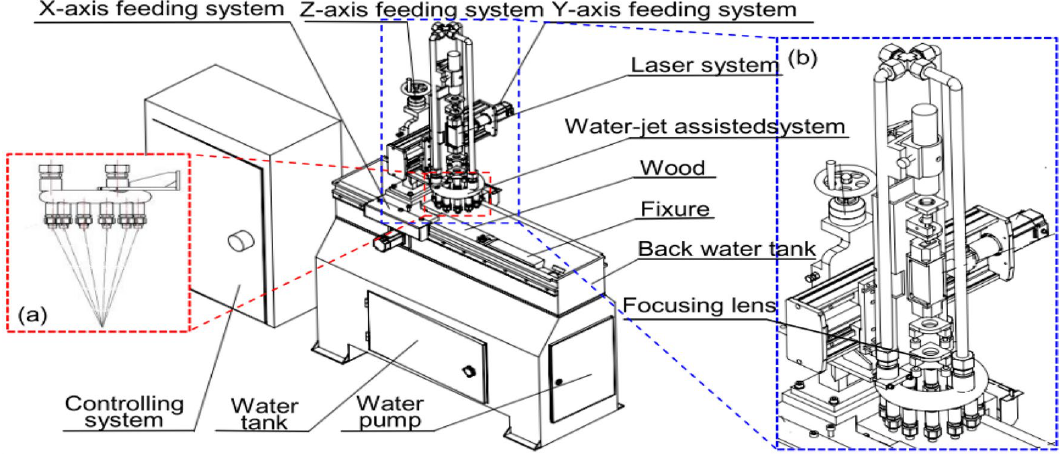
Fig. 3 Diagram of CNC WJGL processing test bench [26]. a Structural drawing of the nozzle, b structural illustration of the waterjet-guided laser